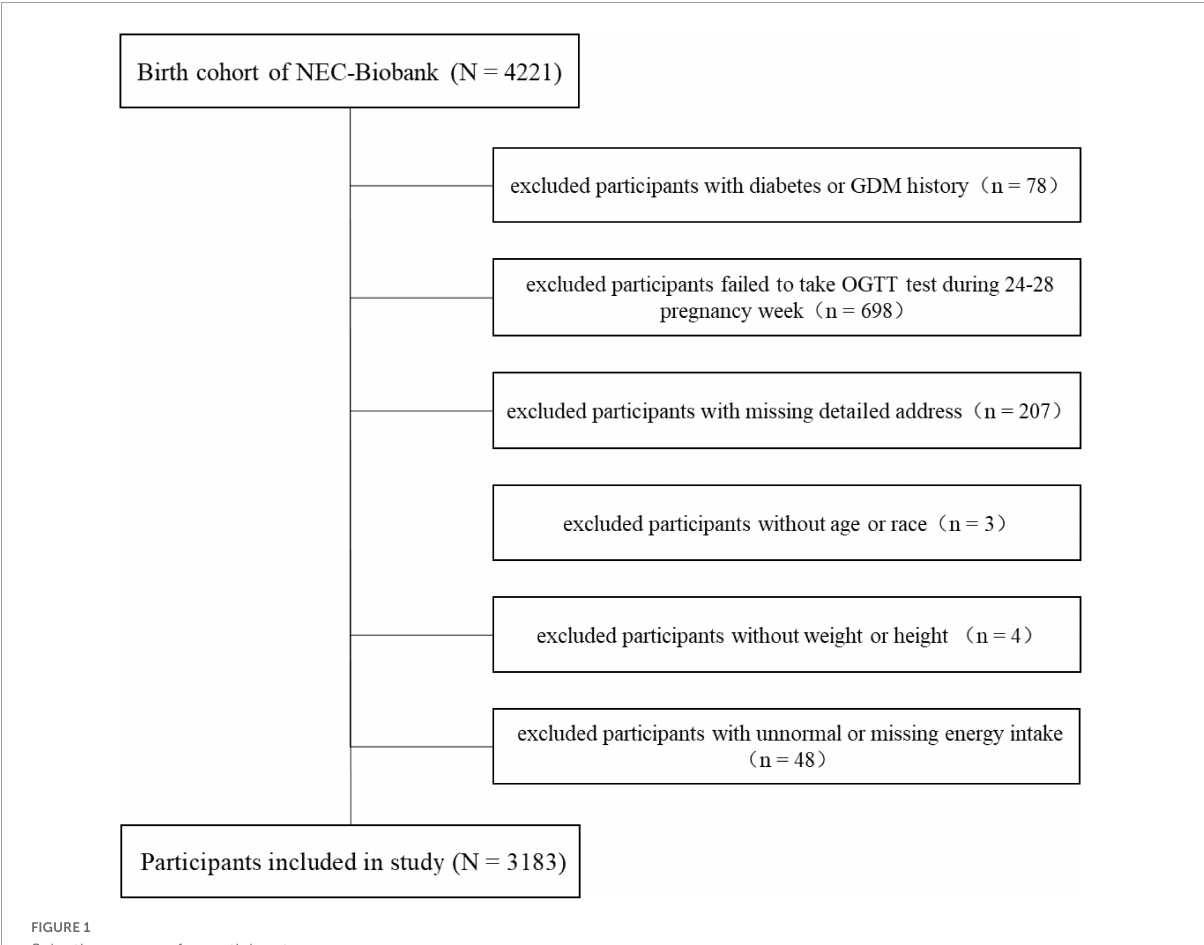
FIGURE1 Selection process for